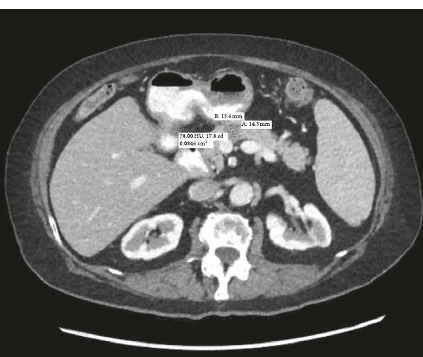
Figure 1: CT abdo/pelvis: hypodense lesions within the pancreatic body and medial aspect of the pancreatic head which are con- cerning for a neoplastic process.